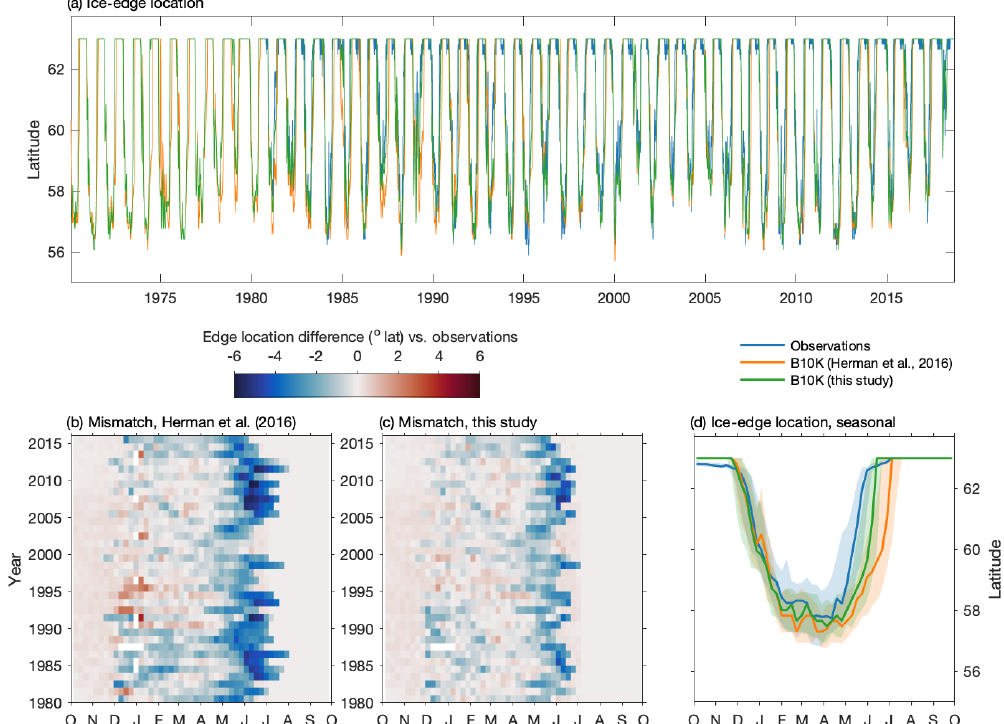
Figure 3. Skill assessment of the location of the sea ice edge along 170 ◦ W. Panel (a) depicts the entire time series in satellite observations, the Hermann et al. (2016) version of the Bering10K model, and the current version of the Bering10K model. Panels (b) and (c) indicate the seasonal and interannual mismatch between the location of the ice edge in the model and the observations. Panel (d) shows the seasonal median (line) and 25th–75th percentile ranges (shaded region) of ice-edge extent across the three